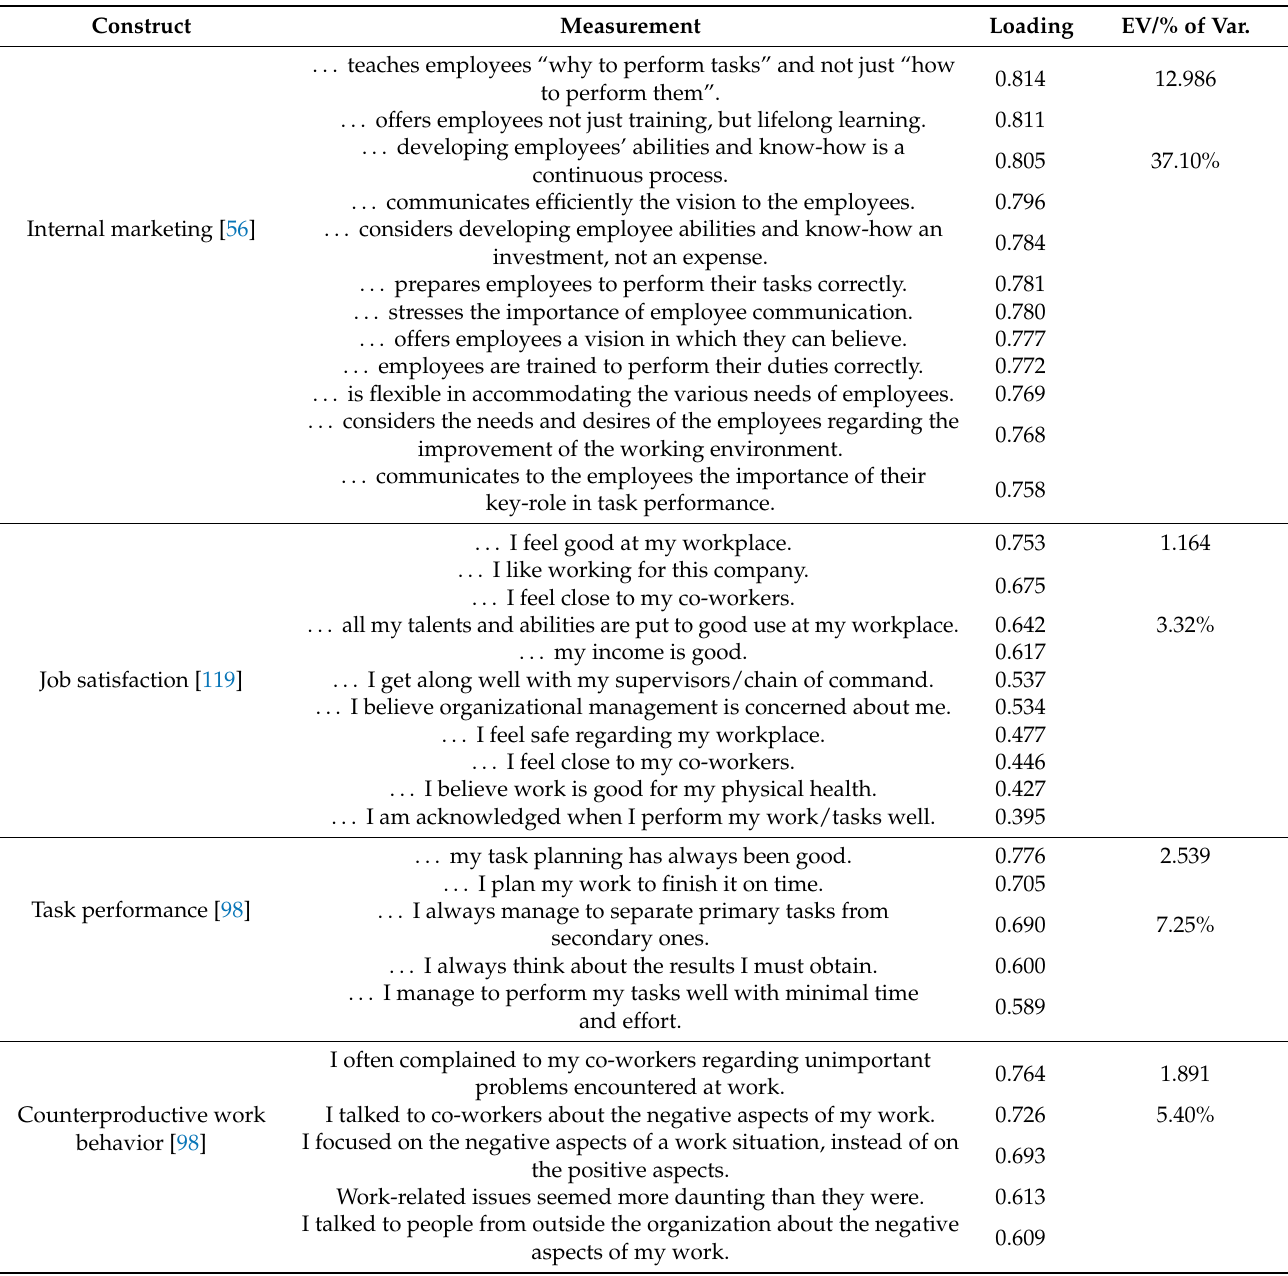
Table 3. Operationalisation of